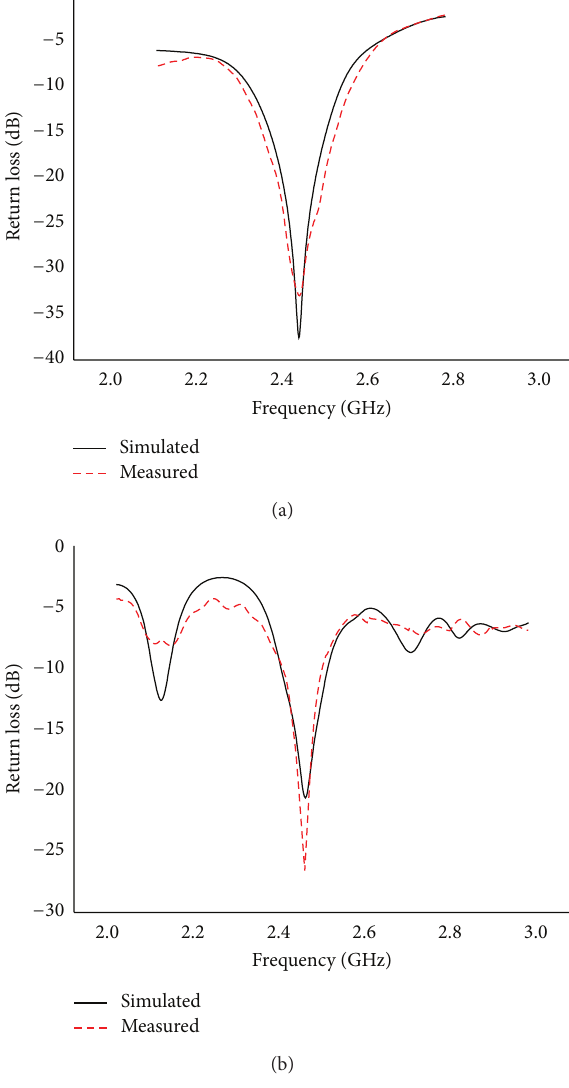
Figure 8: Simulated and measured return loss. (a) Without addi- tional ground and (b) with additional